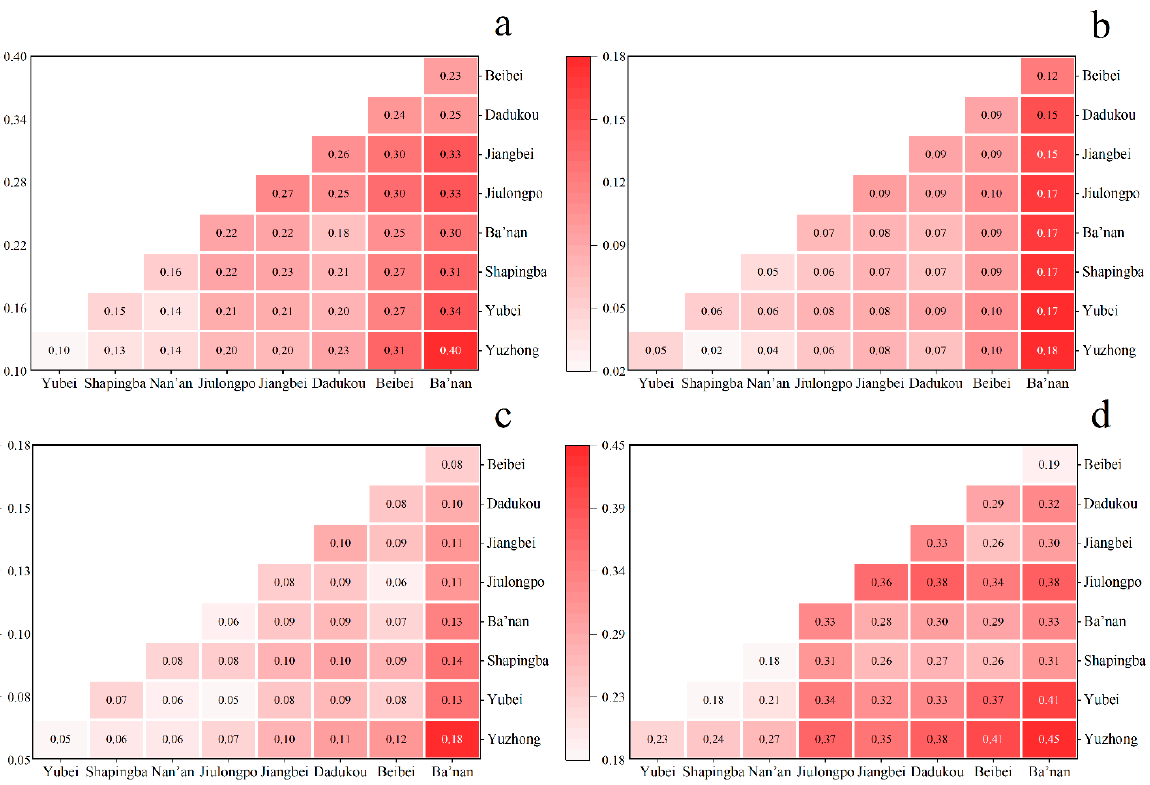
Figure 6. Inter-regional differences of The Dagum Gini coefficient. ( a ) Rail Transit mode; ( b ) private car mode; ( c ) bus mode and ( d ) walk mode.